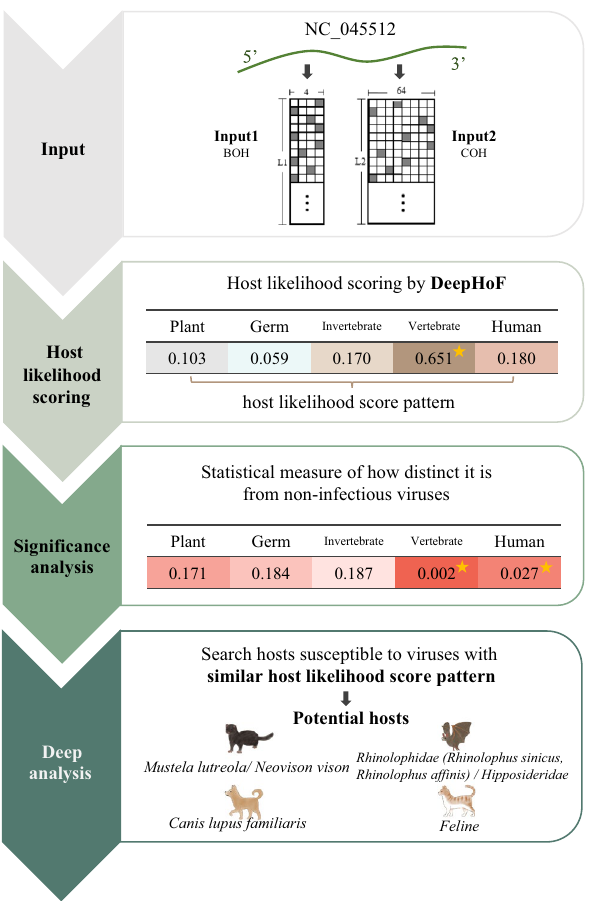
Figure 2. The workflow of application of DeepHoF on NC_045512. In the application of DeepHoF on SARS-CoV-2 NC_045512, the whole genome of NC_045512 was the only input required by the pre-trained DeepHoF model and coded into BOH and COH matrix for BiPathCNN network. DeepHoF output the host likelihood scores of NC_045512 on five host types respectively and the corresponding significance. The hosts of NC_045512 were predicted to be non-human vertebrates and humans with p values less than 0.05. Simultaneously, NC_045512 was characterized by its host likelihood score profile. Via deep analysis of host likelihood score, Mustela lutreola/Neovison vison, Rhinolophus sinicus, Canis lupus familiaris, Hipposideros pomona, Rhinolophus affinis and Felidae were output as the probable hosts of NC_045512. BOH base one-hot matrix, COH codon one-hot